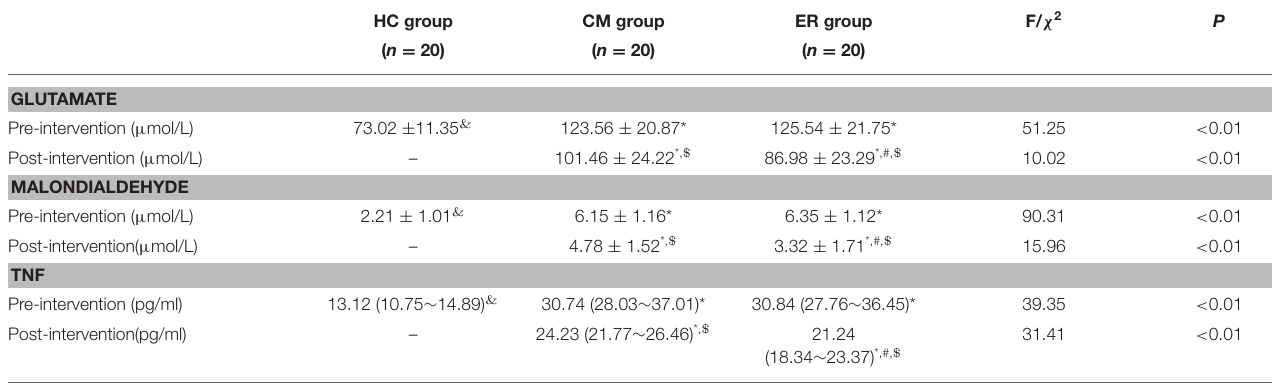
TABLE 3 | The results of serum indexes in each group pre-intervention and